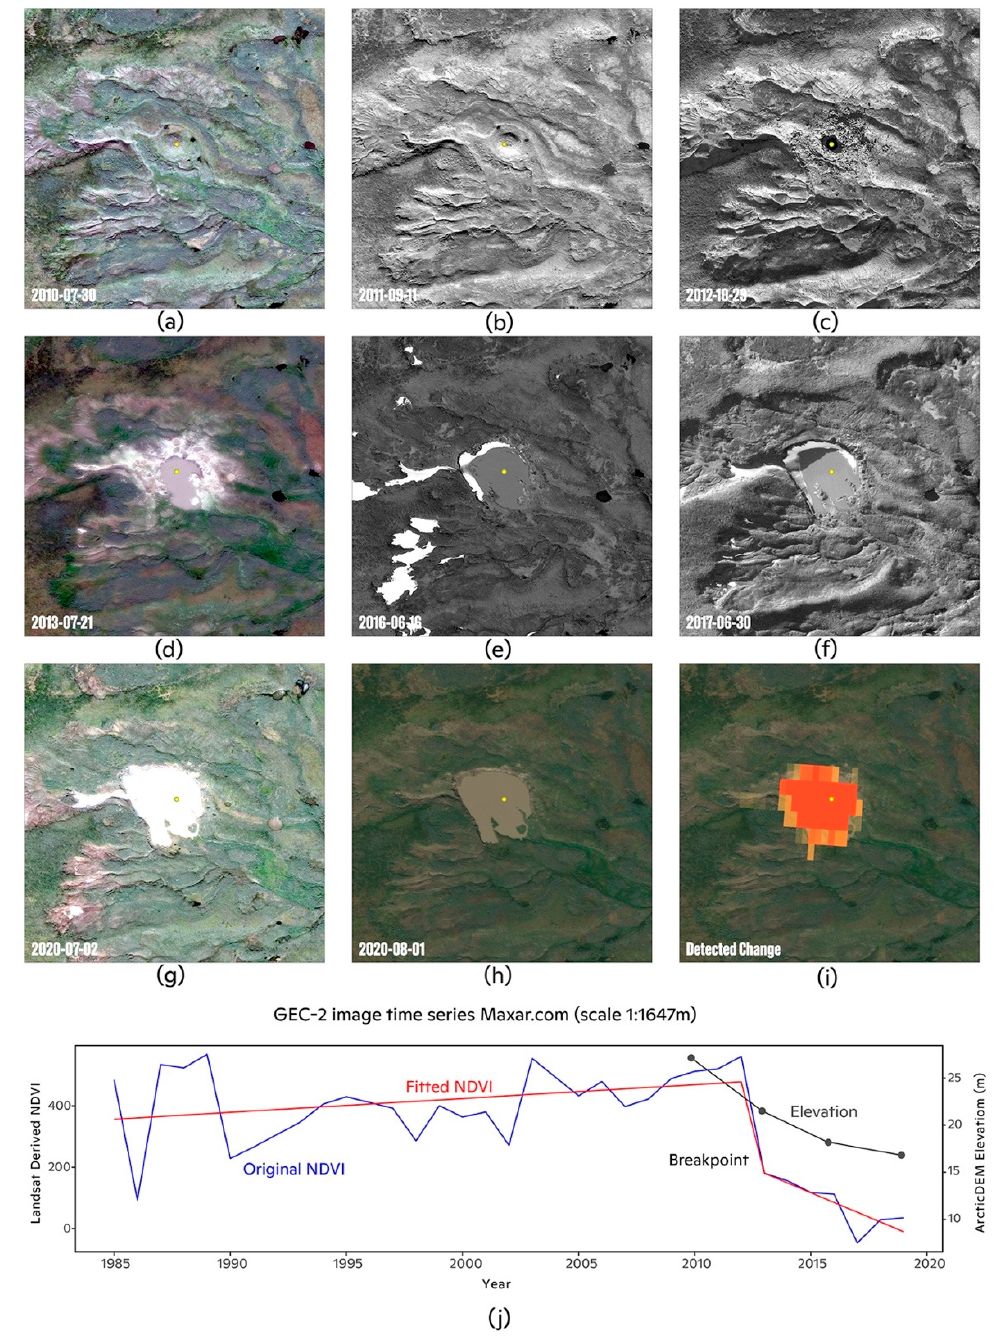
Figure 6. Time-series of high-resolution satellite imagery showing the development of GEC-2 from July 2010 (top left image) to August 2020 (bottom center image). Image series shows the mound predecessor ( a , b ) prior to GEC formation ( c ), and subsequent lake formation and expansion ( d – h ). Image on the bottom right shows a cluster of change pixels superimposed on the lake formed by GEC-2 ( i ). Chart at the bottom ( j ) shows the original trends and fitted trends (by LandTrendr) in Landsat-derived NDVI (scaled from − 1000 to 1000), the breakpoint identified by LandTrendr, and corresponding trends in elevation extracted from the corrected ArcticDEM strips. Imagery © 2020, DigitalGlobe.